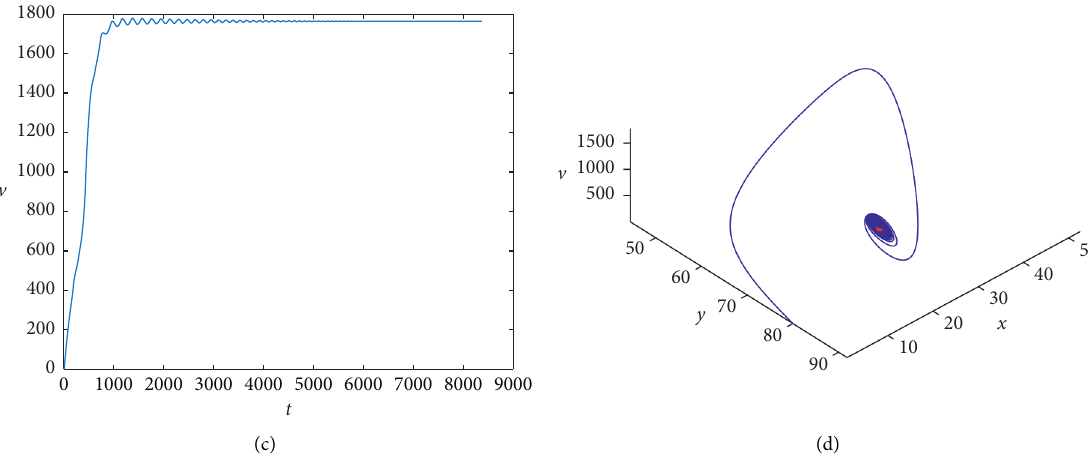
Figure 3: Illustration of basic behavior of solutions of system (4) with τ � 0 . 52, where R � 8 . 4 > 1 (the initial condition is (1, 80, 0.01)): (a) time series of x ( t ), (b) time series of y ( t ), (c) time series of v ( t ), and (d) phase trajectories of x ( t ), y ( t ), and v ( t ).